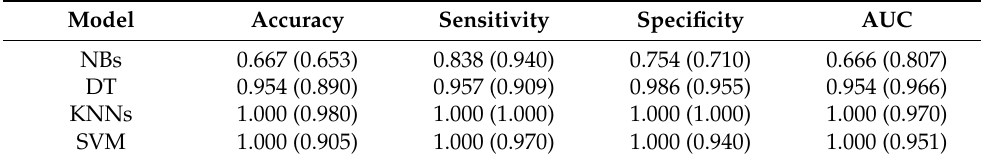
Table 4. Measuring indicators of classifying